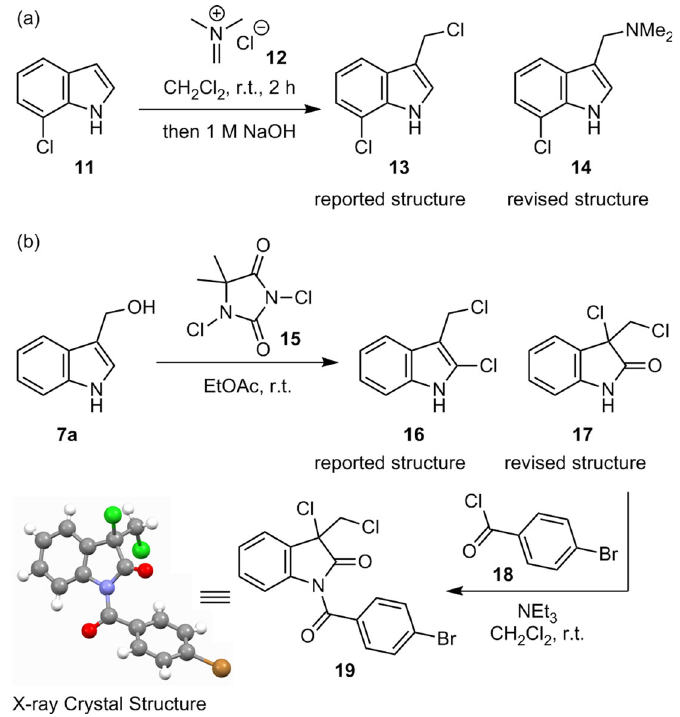
Fig. 3 Examination of the reported syntheses of (1 H -indol-3-yl)methyl chloride analogues. a Preparation of 13 using iminium chloride 12 reported by Degterev et al. b Preparation of 16 using 15 reported by Jiang et